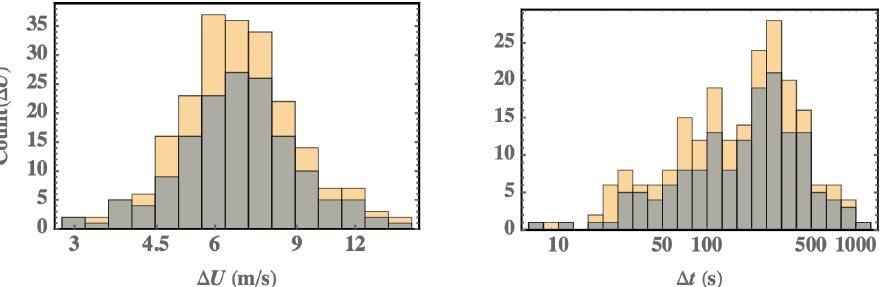
Figure 1. Distributions of ramp amplitude and rise time. Yellow: all events; blue/gray: excluding events which exceed cutout or start above rated speed.